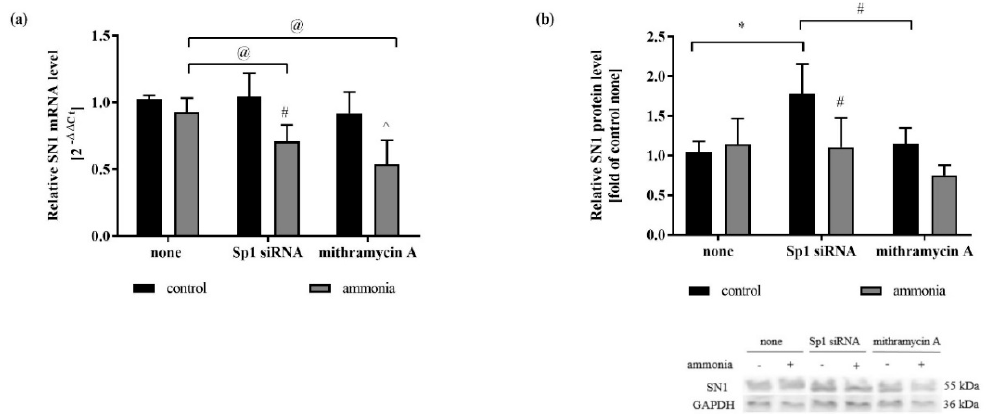
Figure 3. The effect of Sp1 transcription factor silencing (Sp1 siRNA) or inhibition (mithramycin A) on SN1 expression in mouse astrocytes treated or not with 5 mM ammonia for 24 h. ( a ) SN1 mRNA level. ( b ) SN1 protein level. Results are mean ± SD ( n = 4). * p < 0.05 vs. control none, (@) p < 0.05 vs. ammonia none, (#) p < 0.05 vs. control Sp1 siRNA; (^) p<0.05 vs. control mithramycin A; Two-Way ANOVA and Bonferroni post-hoc test.